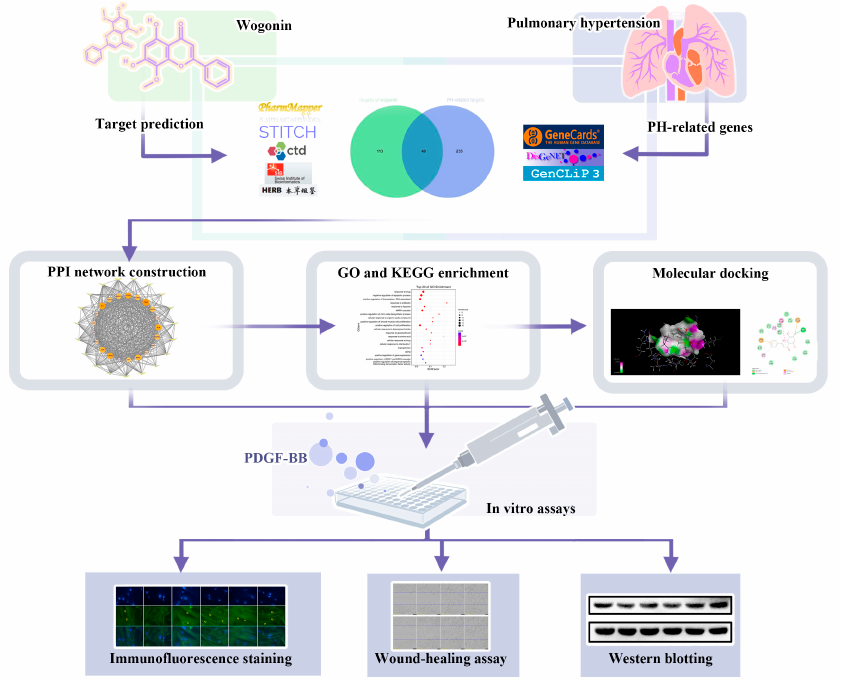
Figure 1. The experimental flow of this study. PPI: protein–protein interaction; GO: gene-ontology; KEGG: kyoto encyclopedia of genes and genomes; PDGF-BB: platelet-derived growth factor-BB.